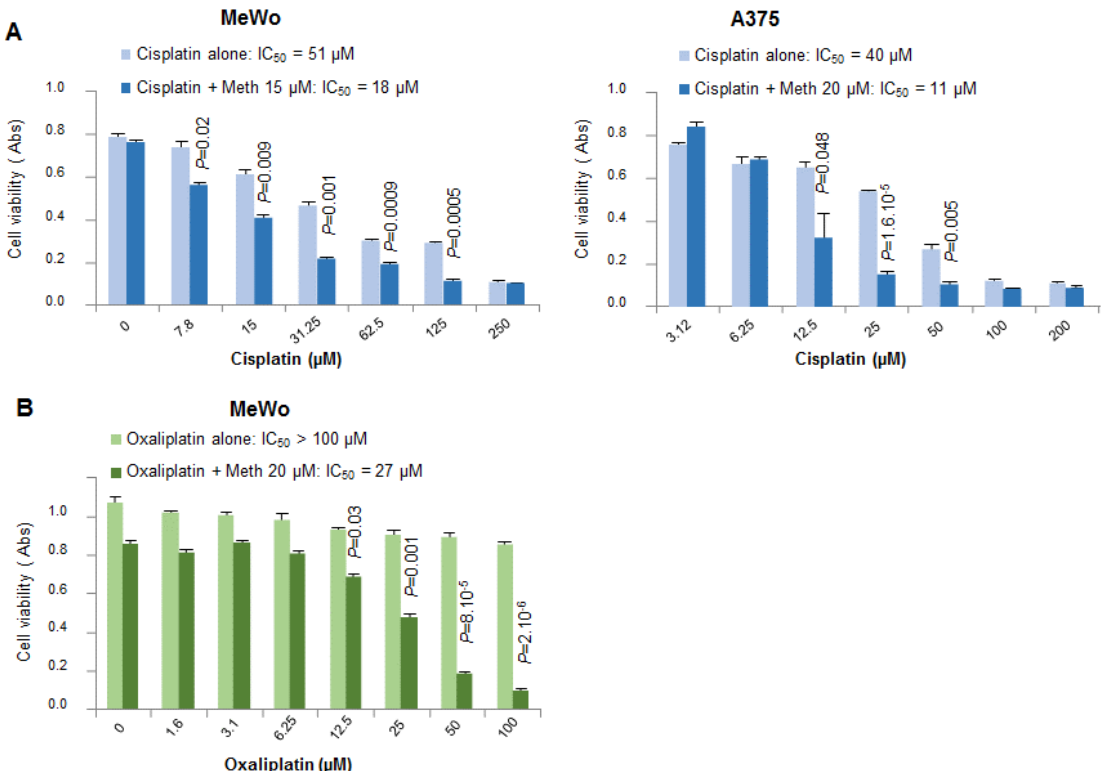
Figure 6. Methiothepin increases the sensitivity of melanoma cells to cisplatin and oxaliplatin. Cell viability was measured after 48 h’ treatment with increasing concentration of cisplatin ( A ) or oxaliplatin ( B ) with or without methiothepin (Meth) on MeWo and A375 melanoma cells. Statistical differences of cell viability without and with methiothepin for each concentration of cisplatin or oxaliplatin were calculated using the student’t t-test . The difference was statistically significant for a p value < 0.05. IC 50 values of cisplatin or oxaliplatin have been calculated in the absence and the presence of methiothepin.